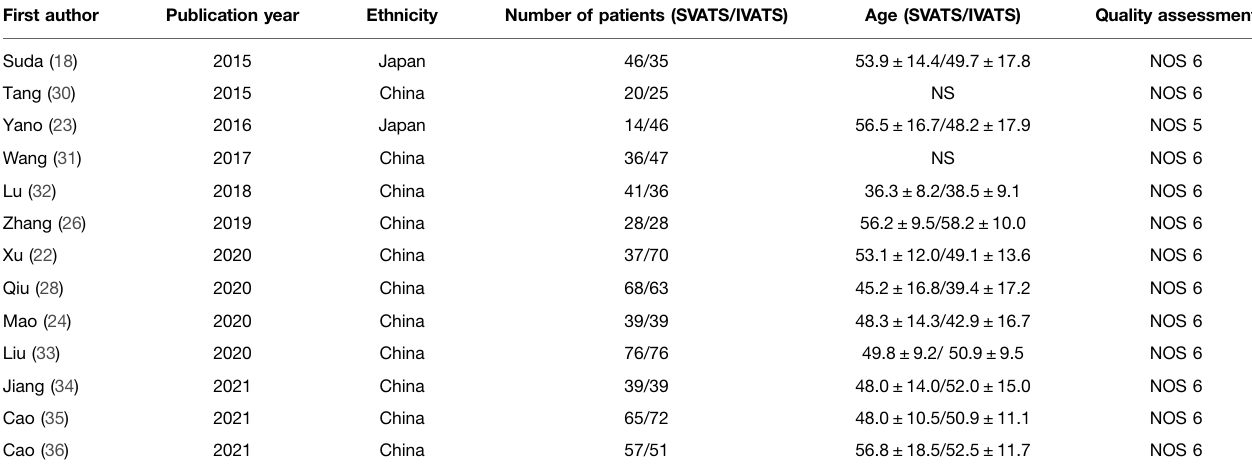
TABLE 1 | Baseline information of included